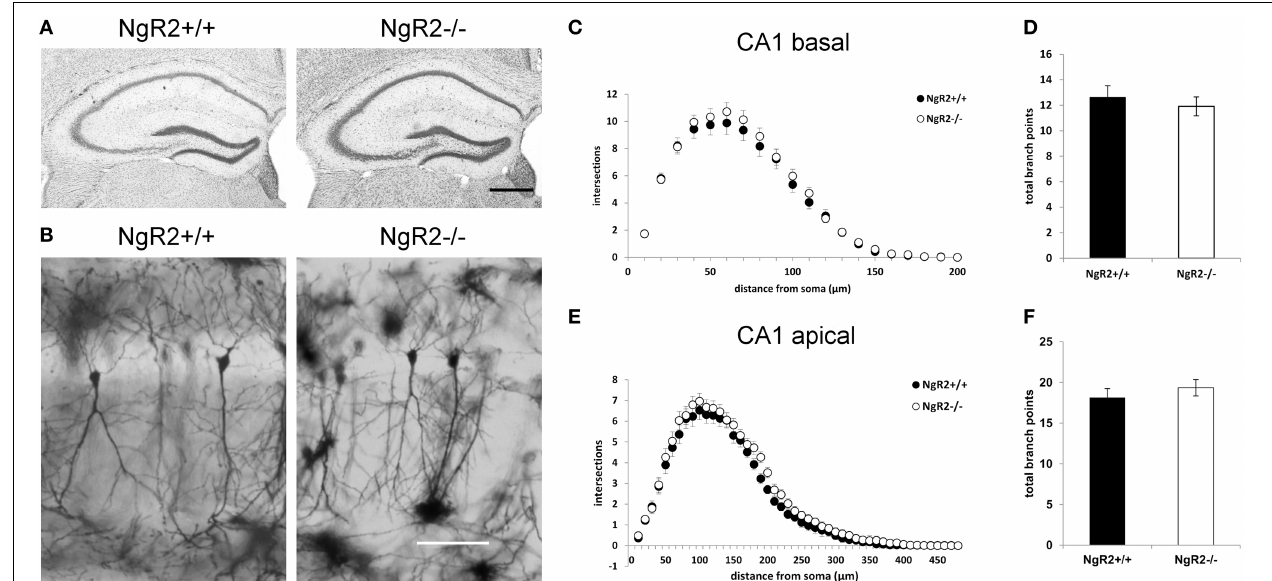
FIGURE 1 | Dendritic morphology of CA1 hippocampal neurons is similar between NgR2 + / + and NgR2 − / − mice. (A) Nissl staining of coronal sections from NgR2 + / + and NgR2 − / − hippocampus. (B) Representative images of Golgi-Cox stained pyramidal cells in hippocampal CA1 region in NgR2 + / + and NgR2 − / − . (C,D) Sholl analysis of dendritic complexity in CA1